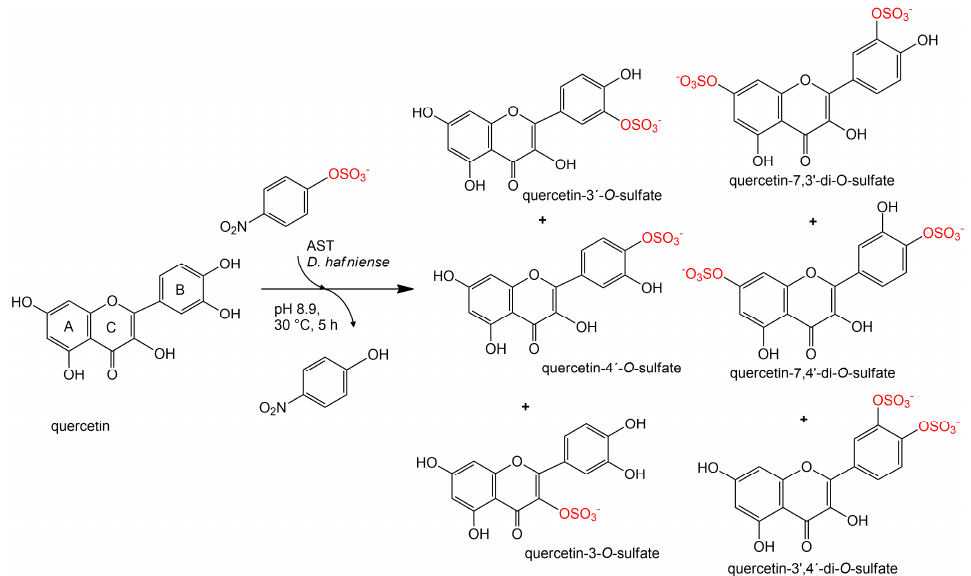
Figure 3. Sulfation of quercetin catalyzed by arylsulfotransferase from Desulfitobacterium hafniense .